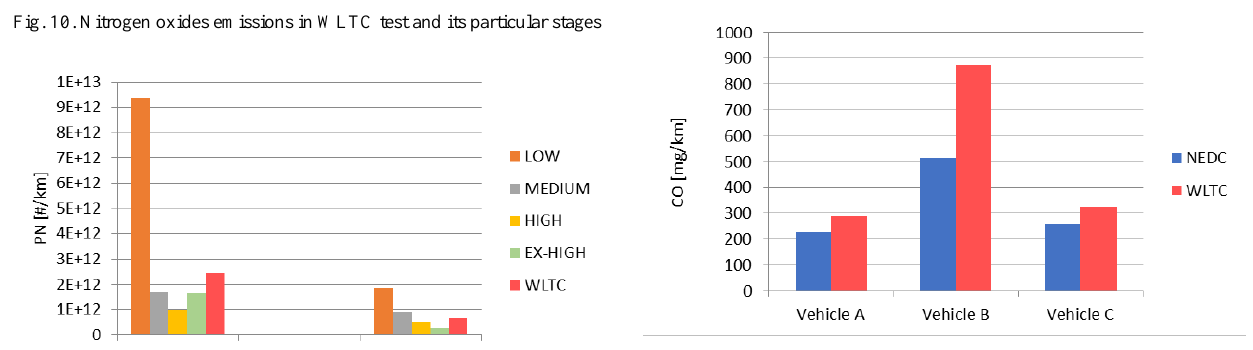
Fig. 13. Carbon monoxide emissions in NEDC and WLTC